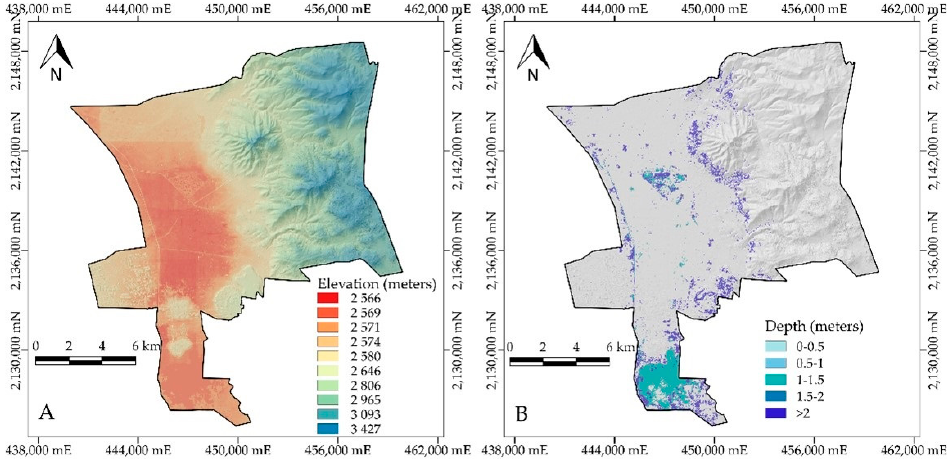
Figure 9. ( A ) Elevation distribution over the study area (DEM from LiDAR) and ( B ) depth of flooded areas.